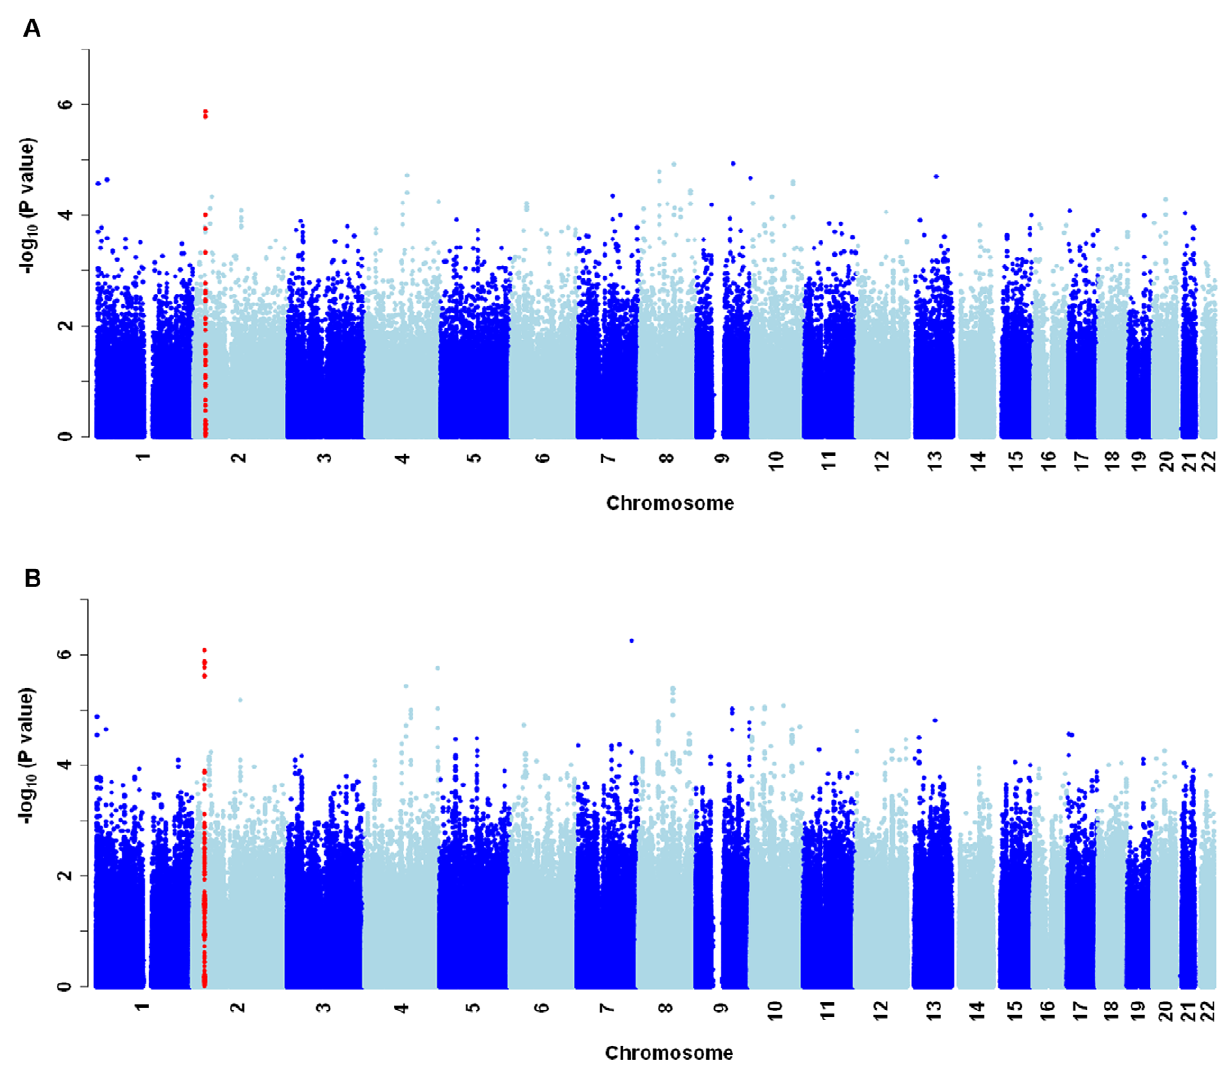
Figure 1. Manhattan plots for the discovery GWAS carried out in the Raine Study. Association analysis was performed on (A) genotyped SNPs, and (B) the full imputed dataset, corrected for the first two principal components to account for population stratification. Plots show 2 log 10 (P values) of association ordered by chromosomal location. Red dots highlight the region of the top hits CAPN14 and GALNT14 on chromosome 2p23.1.